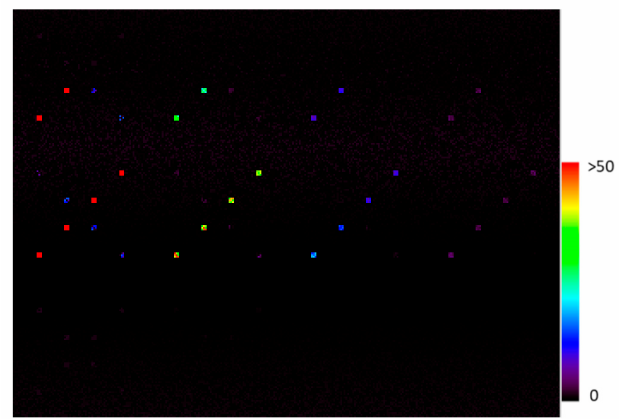
Figure 9. Reconstruction error (percentage).